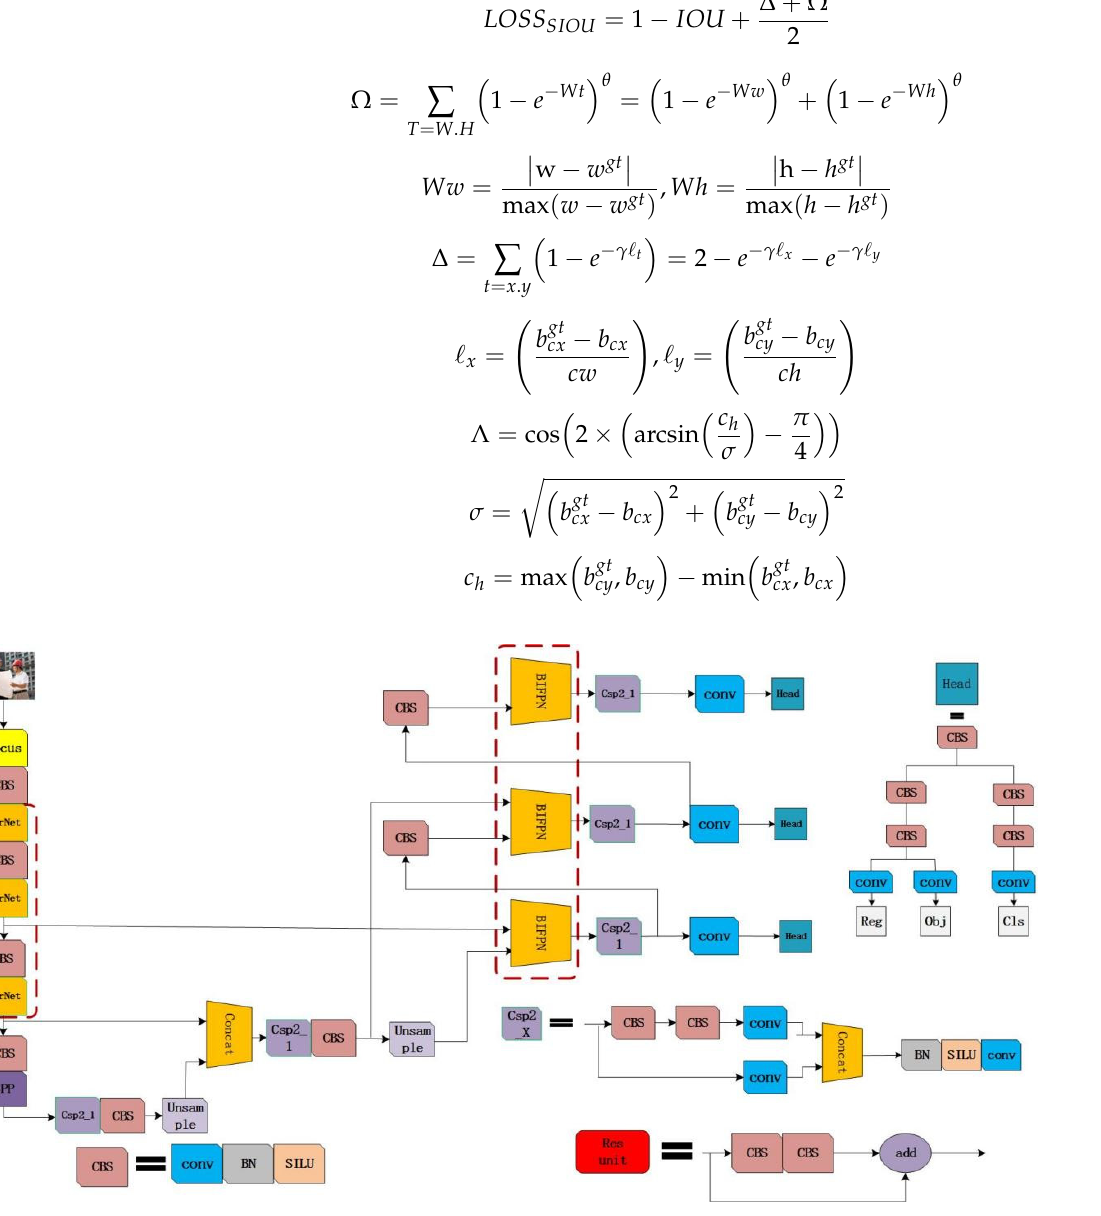
Figure 3. Structure of improved YOLOX-s .